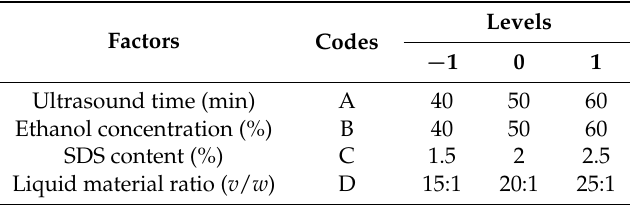
Table 5. Levels and codes of independent variable used for response surface